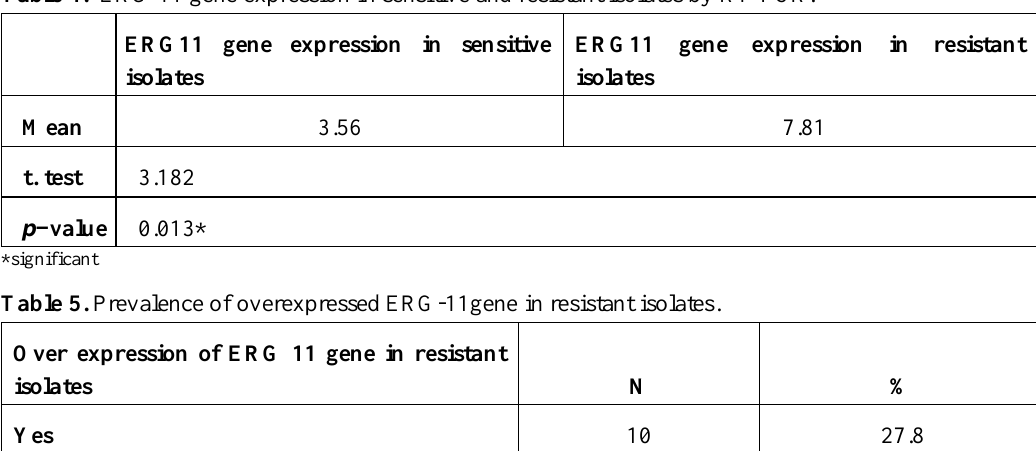
Table 4. ERG-11 gene expression in sensitive and resistant isolates by RT-PCR.